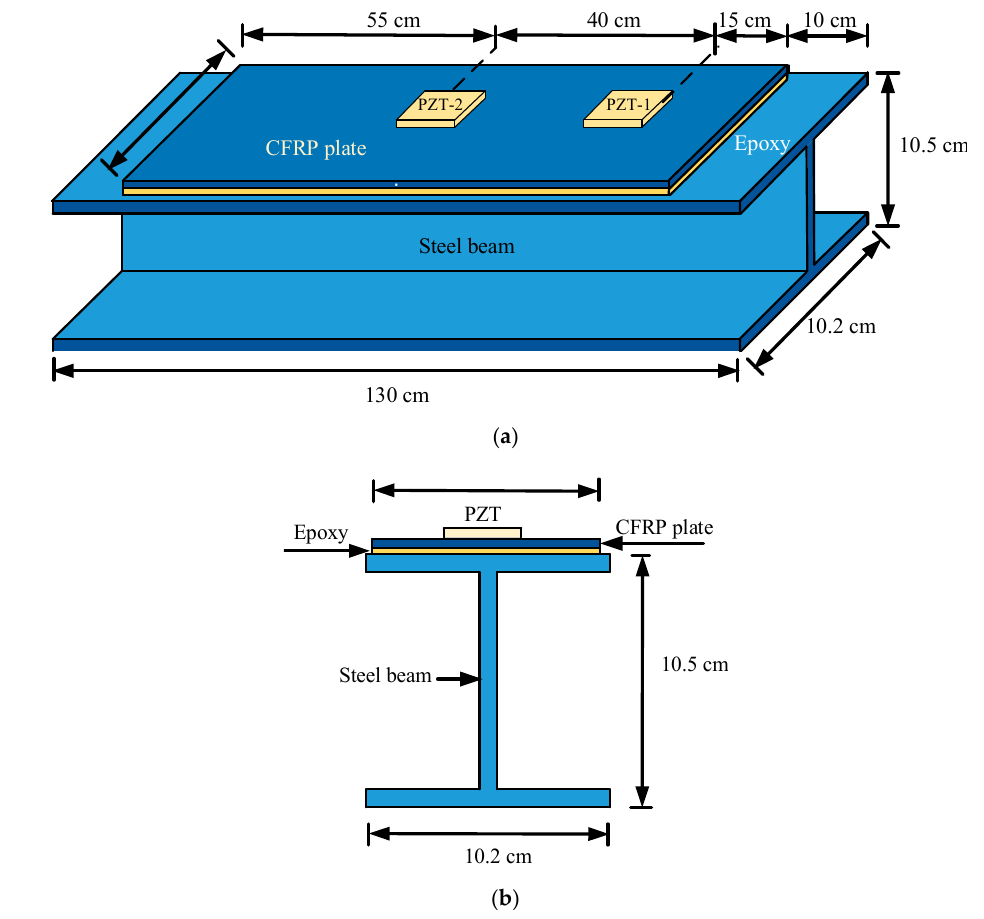
Figure 3. ( a ) CFRP plate strengthened steel beam specimen; ( b ) cross section of the CFRP plate strengthened steel beam.